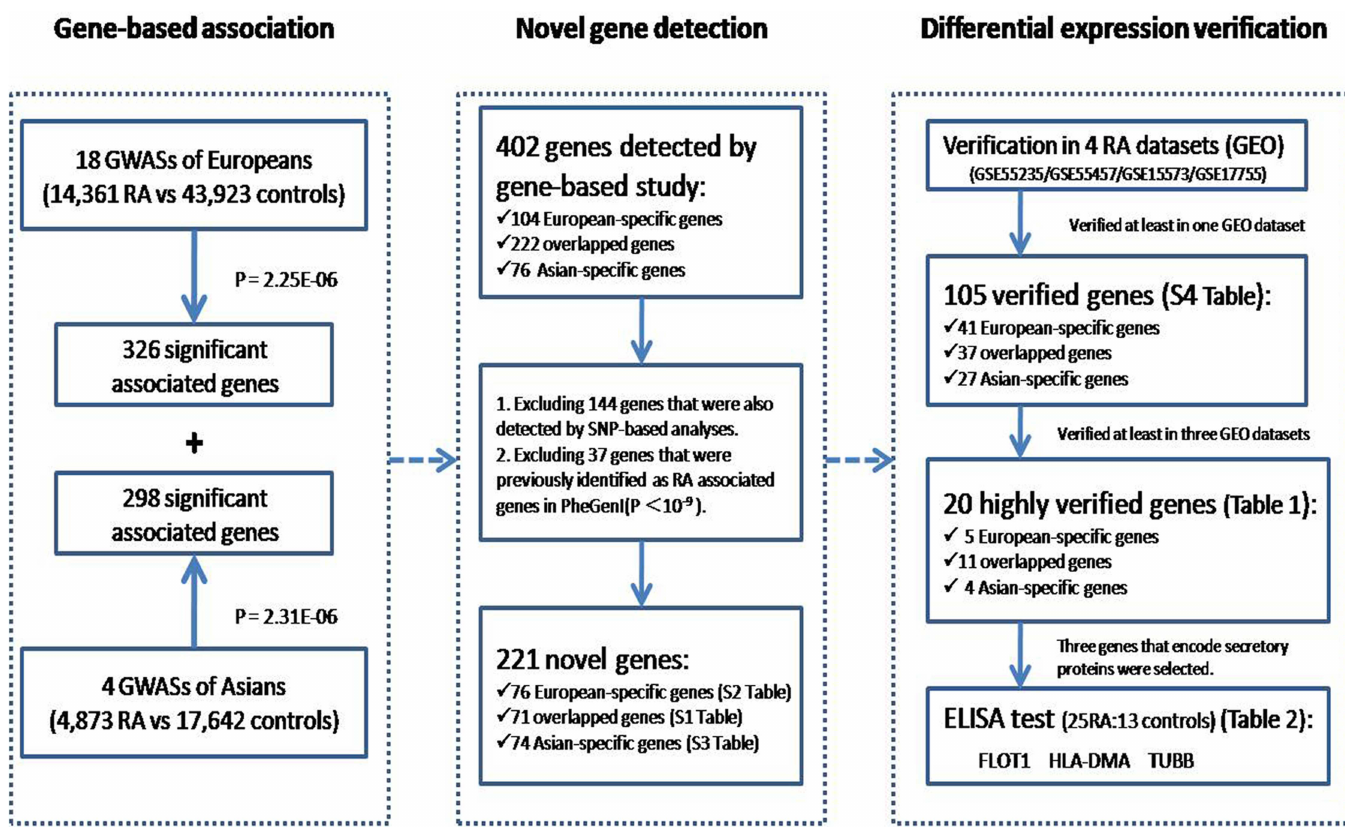
Fig 1. The flow chart of data analysis. European-specific and Asian-specific multivariate gene-basedassociation tests were conductedseparately by using extendedSimes procedure(GATES) [9], KGG 2.5, using raw data of 18 EuropeanGWASs and 4 Asian GWASs. The 221novelgeneswere screenedfrom 402gene-based detected genes. Among the 221genes, the differential expressionof 105 genes was verifiedat least in one of four GEO datasets. The differentialexpressions of 20 geneswere verifiedat least in three of four GEO datasets. Three genes encoding secretory proteins were selectedfrom the 11 ‘highly’verified ‘overlapped’genes. GWASs: genome-wide associationstudies; PheGenI: Phenotype-GenotypeIntegratorhttp://www.ncbi.nlm.nih.gov/gap/ phegeni/;GEO: gene expressionomnibus.